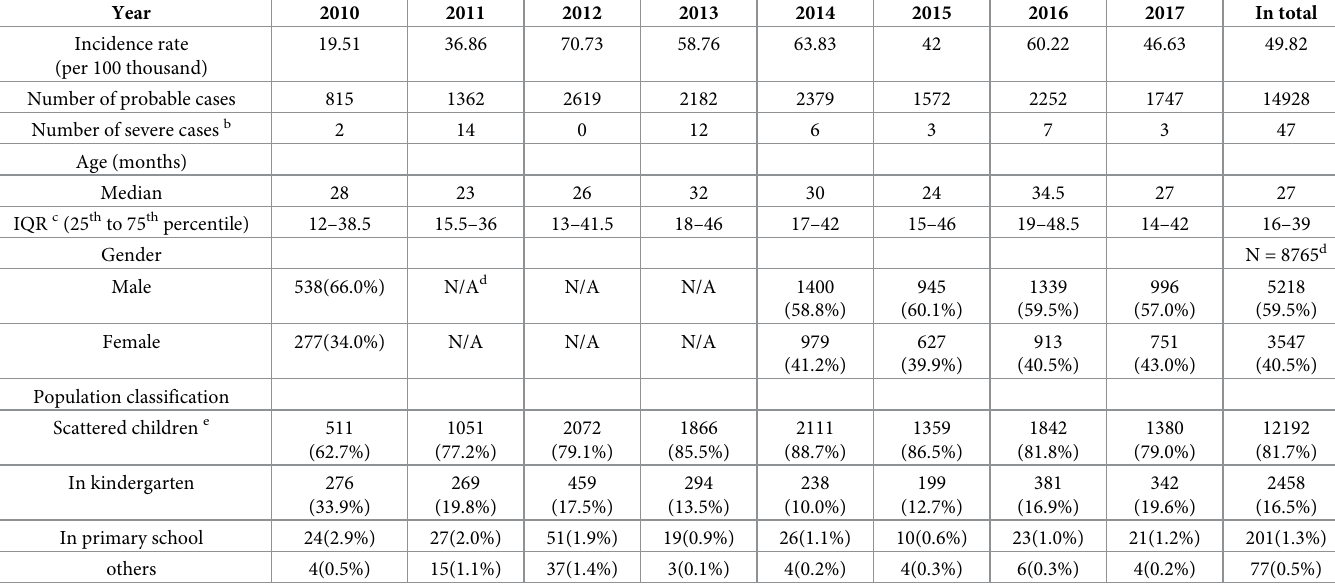
Table 1. The demographic characteristics of probable hand, foot and mouth disease cases in Neijiang, Sichuan, China between 2010 and 2017 (N, %) a